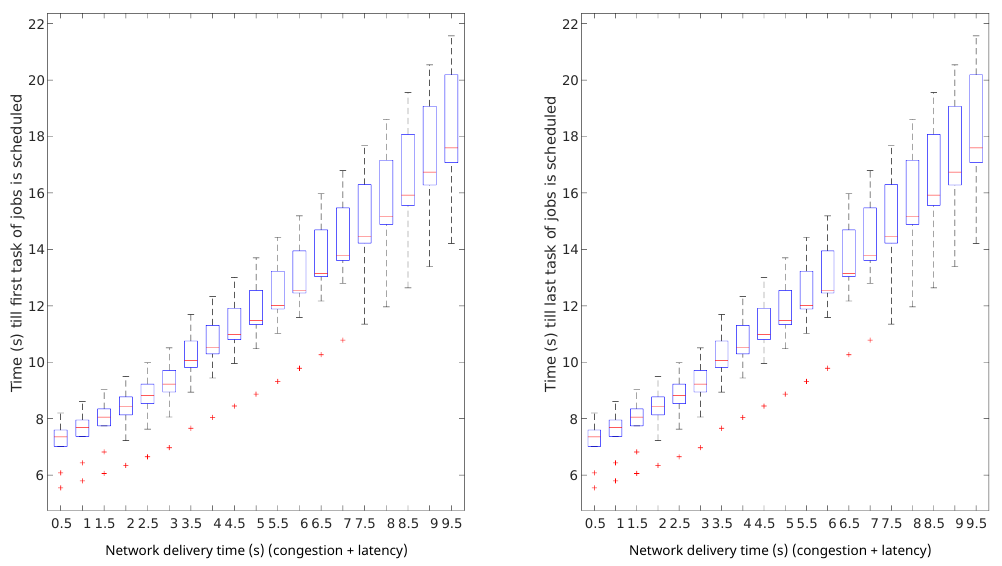
Figure 13. Network impact on queue times in centralised cloud-computing data centres.